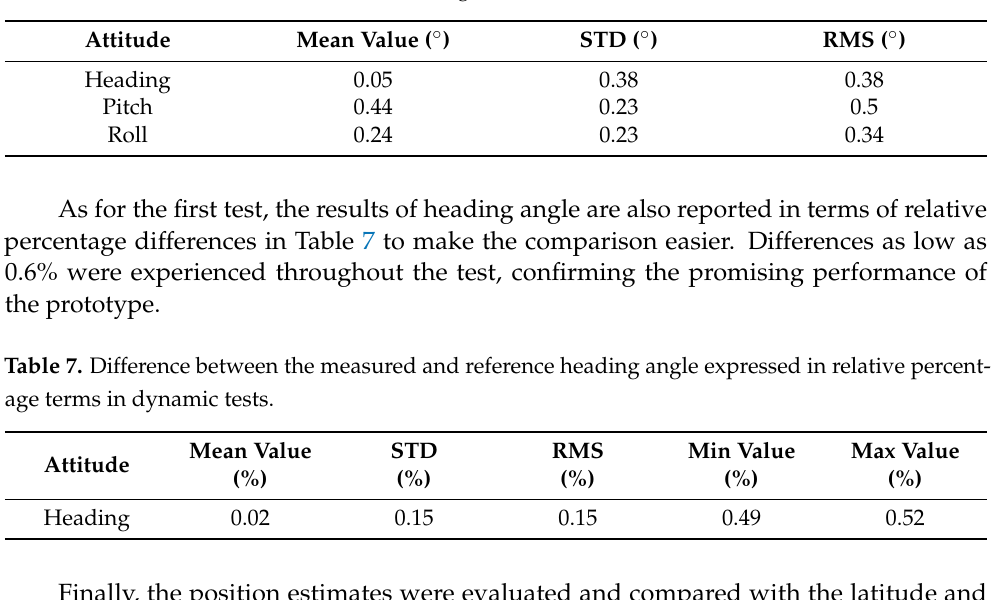
Table 7. Difference between the measured and reference heading angle expressed in relative per- centage terms in dynamic tests.